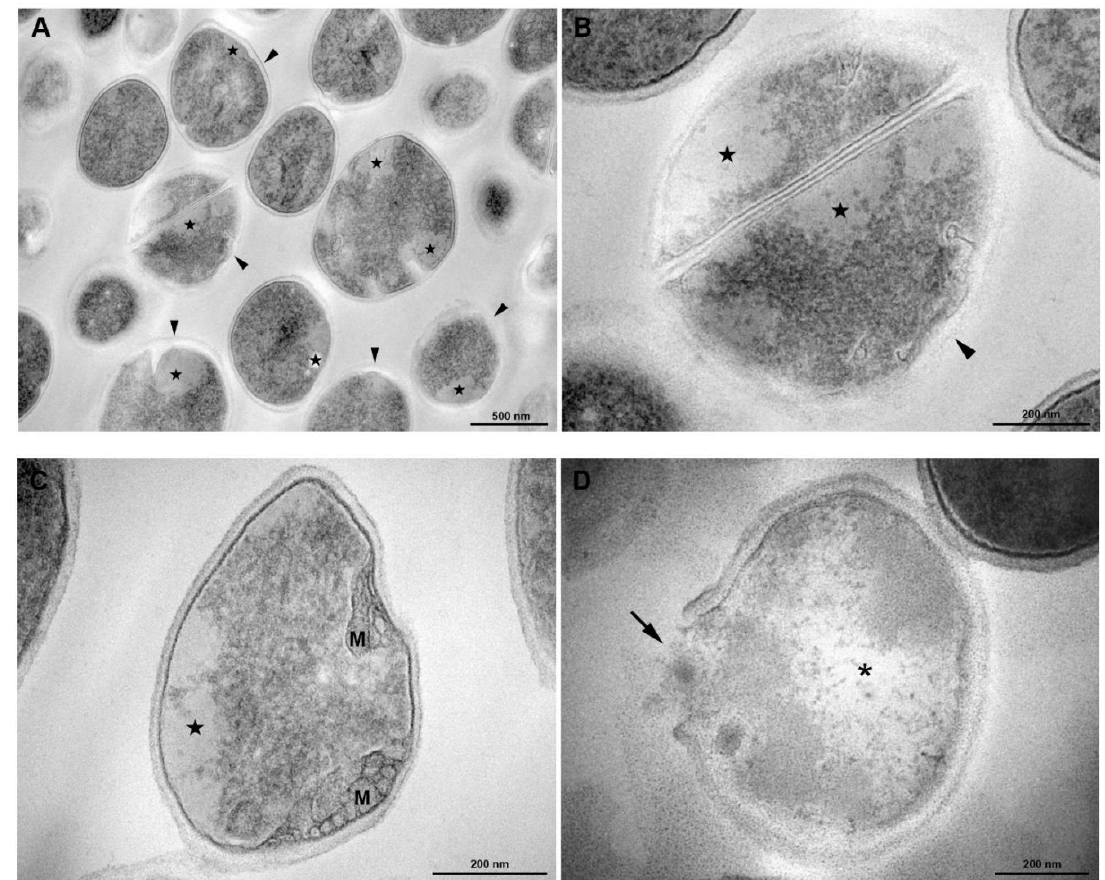
arrowheads). ( B ) Detailed view: the cell has no visible electron-dense inner thin zone of the cell wall (black arrowhead). White arrowhead indicates the plasma membrane. ( C ) Left cell display the normal tripartite cell wall with a heavily stained inner thin zone (arrow), whereas this electron-dense layer is not seen on the right cell (black arrowhead). ( D ) Inset of the Figure C. White arrowhead, plasma membrane. Bars: A: 500 nm; B,C: 200 nm; D: 100 nm.